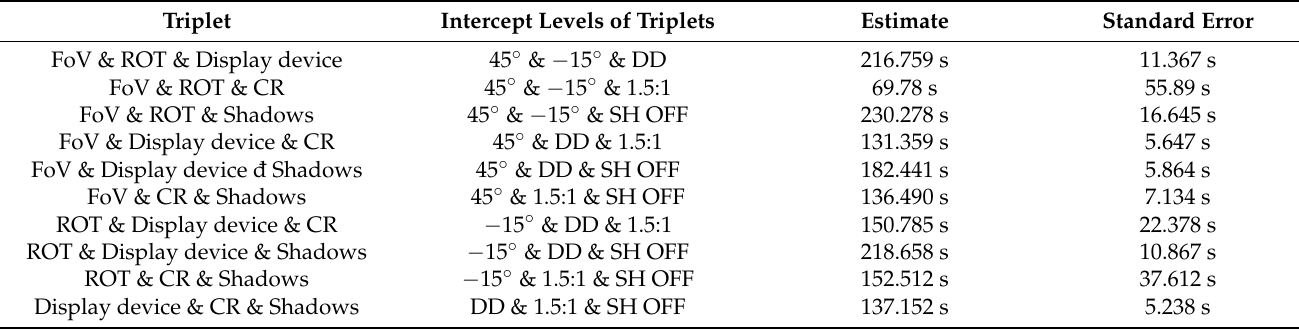
Table 3. The investigated triplets, their intercept values, estimates, and standard